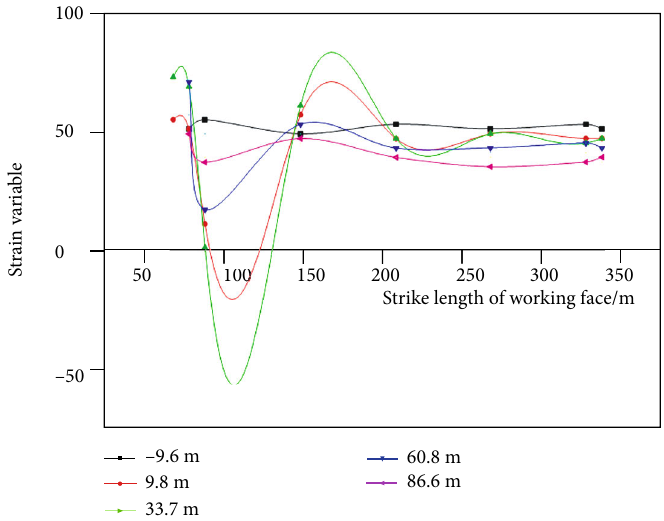
Figure 4: The stress variation curve of 1200 m deep mining model when advancing